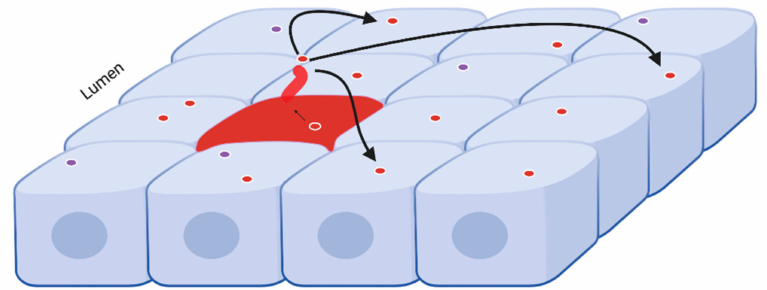
Figure 5. Model of EV signaling in renal tubule. Picture depicting the apical surface of tubule cells. The blue cells are unstressed intercalated cells, while the red cell depicts a principal cell (note primary cilia) experiencing physiological stress, such as caused by the loss of a Tsc gene activity. The darker red circles represent EVs from the stressed cell (red arrow), while the light blue circles represent EVs from cells that are not stressed. The EVs from the stressed cell carry messaging to help surrounding cells deal with the stressor, and to replace the cell that may succumb to the